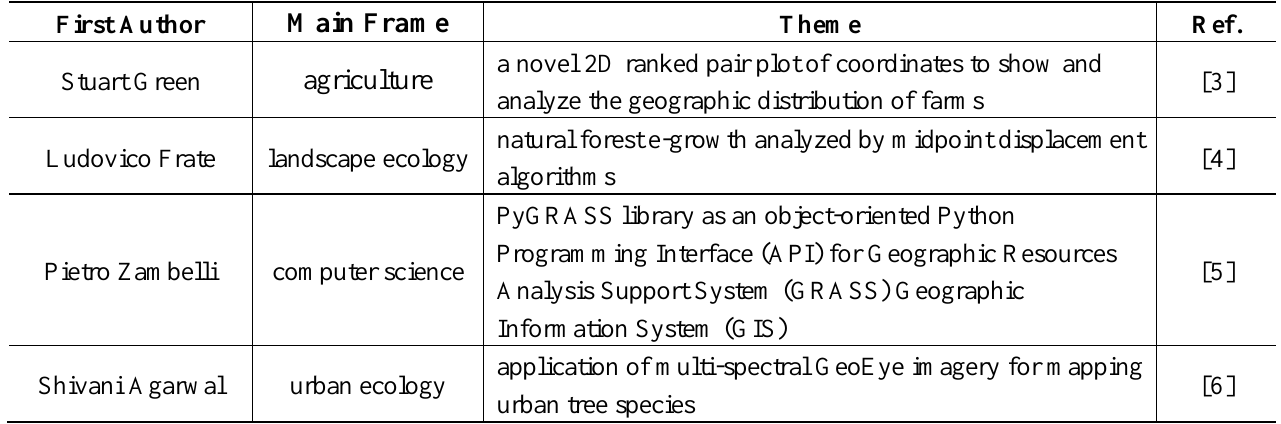
Table 1 attempts to summarize the focus of each of the articles published. Table 1. Summary of the papers published in the special